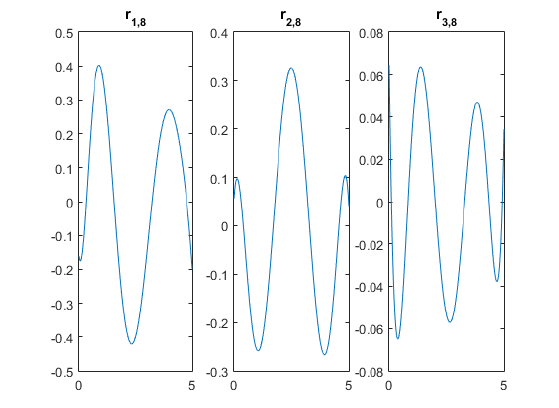
Figure 4. Residual, r 9 = Dy 9 , produced by the Tau method for the state variables x 1 , x 2 and x 3 .